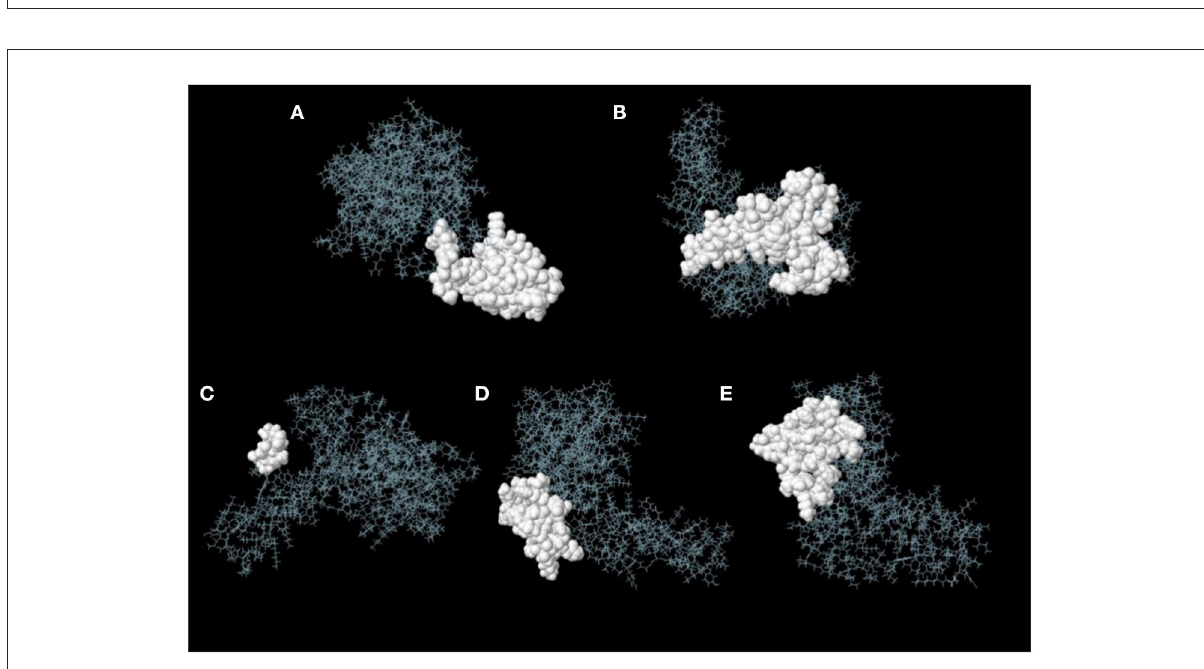
FIGURE7 Discontinuous B-cell epitopes of vaccine constructs predicted by ElliPro. (A–E) The epitopes are represented by a white surface. The gray sticks correspond to the remainder of the protein.